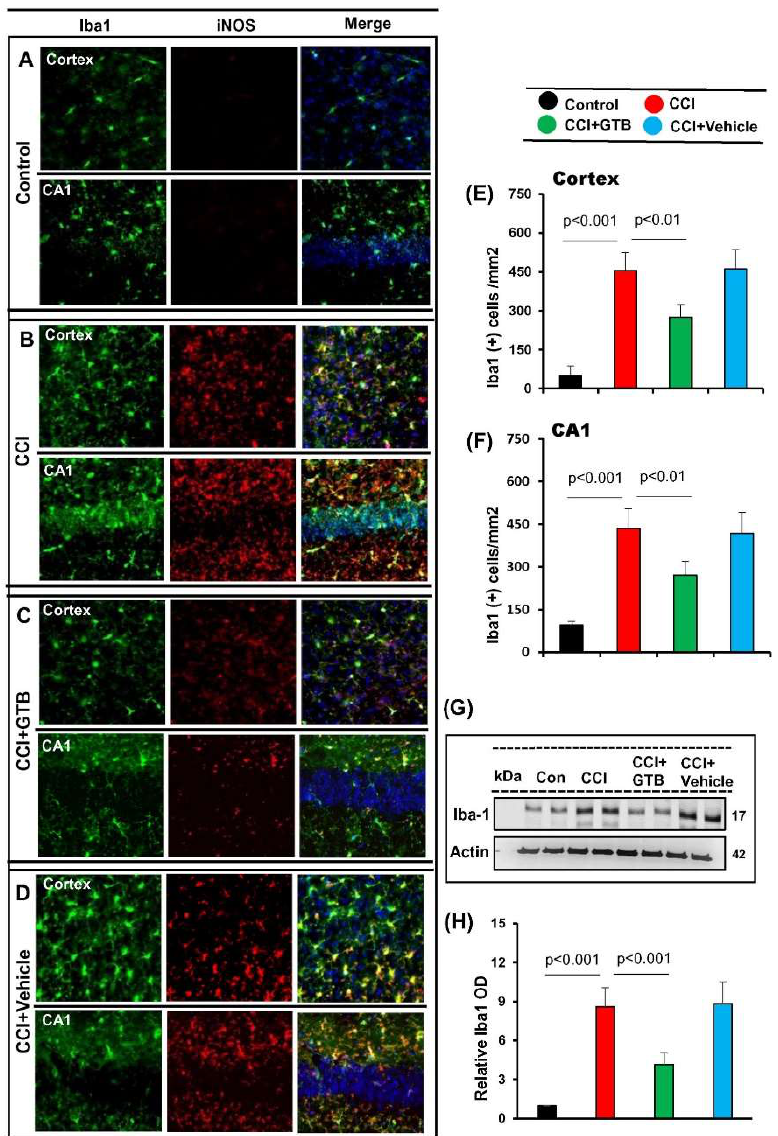
Figure 2. Oral GTB decreases microglial activation in vivo in the cortex and hippocampus of mice with TBI. TBI was induced in mice by CCI injury and after 24 h of injury, mice were treated with 50 mg/kg/day of GTB via oral gavage. Seven days after GTB treatment, brain sections were double labeled for Iba1 and iNOS (( A ), control; ( B ), CCI; ( C ), CCI + GTB; ( D ), CCI + Vehicle). Cells positive for Iba1 were counted in cortex ( E ) and CA1 region of hippocampus ( F ). Results represent analysis of two sections of each of six mice per group. Tissue extracts of hippocampal region from all groups of mice (n = 4 per group) were immunoblotted for Iba1 ( G ). Actin was run as a loading control. Bands were scanned, and values (Iba1/Actin) ( H ) presented as relative to